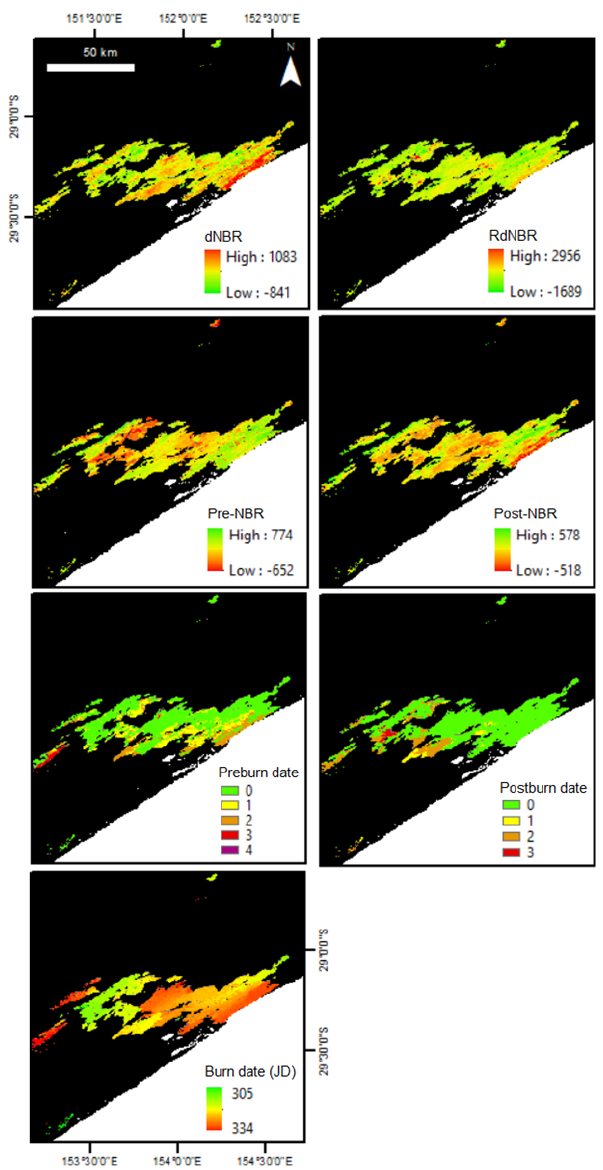
Figure 3. Example of the layers included in a MOSEV scene (A2019305.h31v11) representing some of the 2019 wildfires in Australia (New South Wales). Spectral indices dNBR, RdNBR, pre- NBR and post-NBR are unitless. The pre-burn and post-burn dates indicate the number of cycles or iterations necessary to find avail- able NBR values (each cycle added to 0 corresponds to a difference of 8d). The burn date is expressed in Julian days. White areas are water bodies (value of 32767), and black areas are unburned land (value of − 32767).